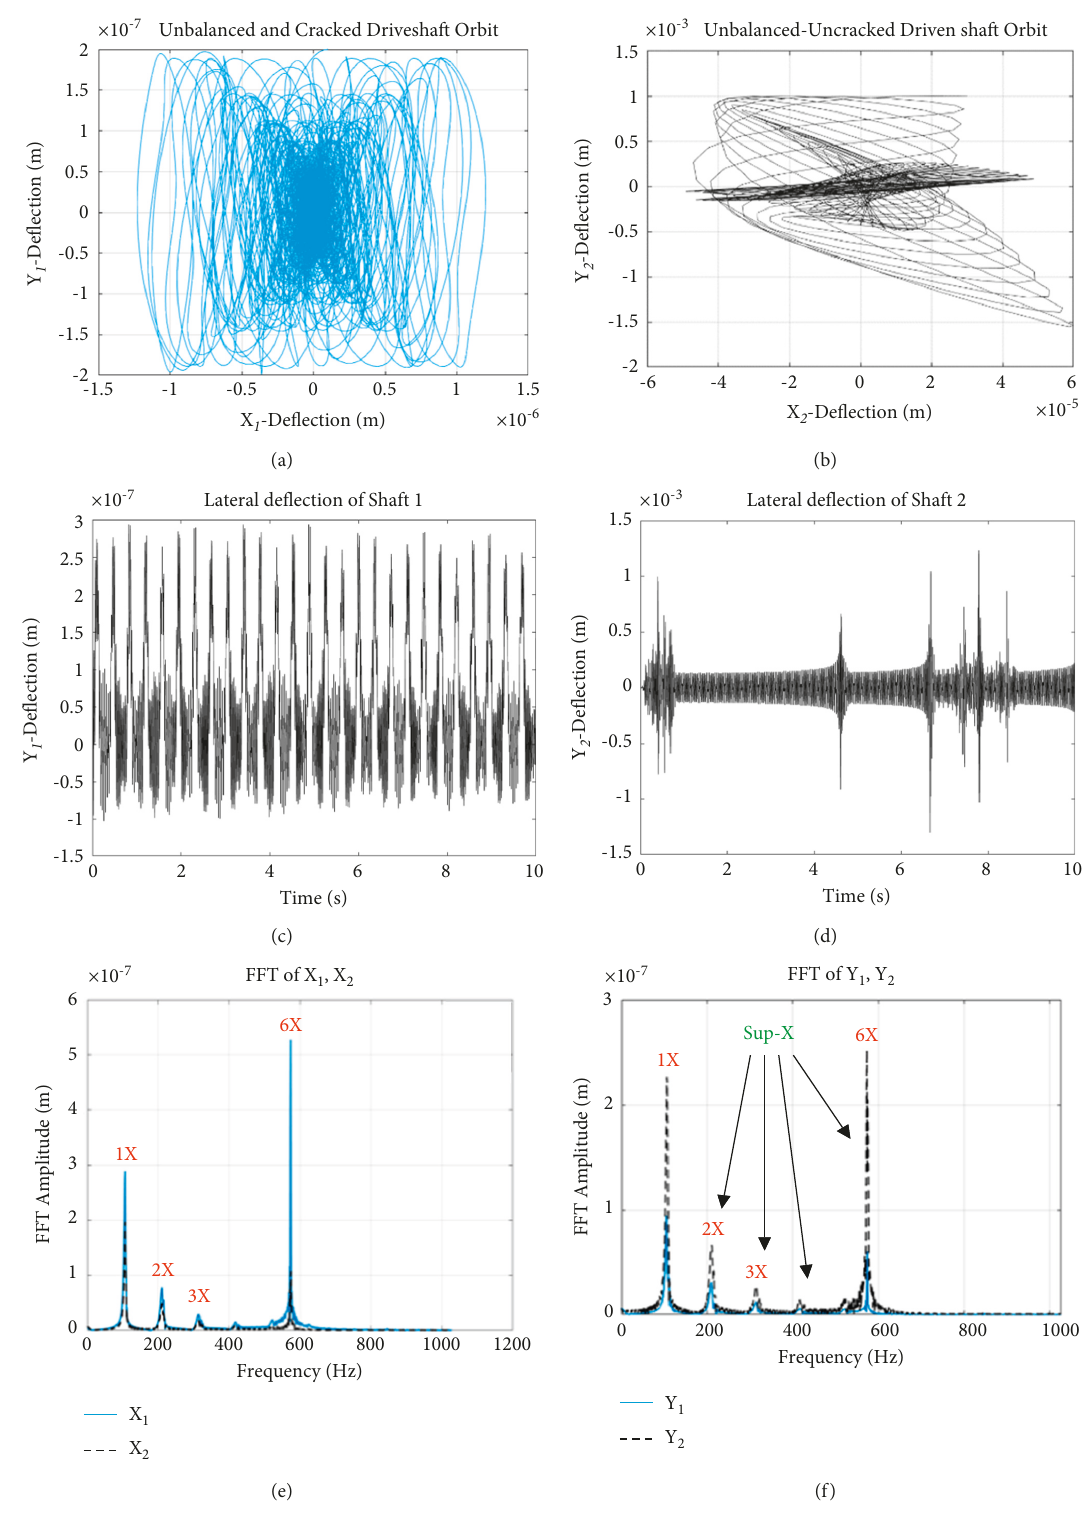
ε 1 c 0 . 3 . (a) The orbit of the unbalanced ( (cid:31) )